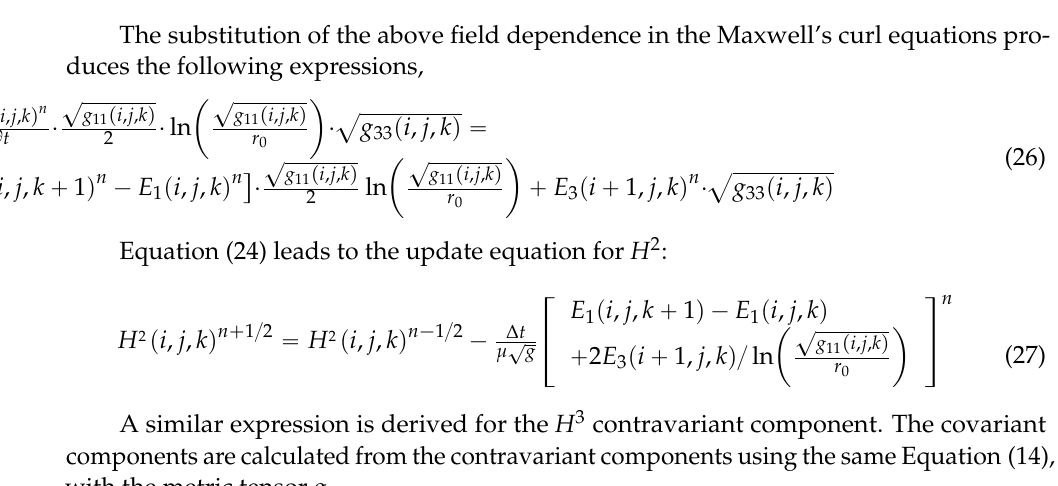
Equation (24) leads to the update equation for H 2 :